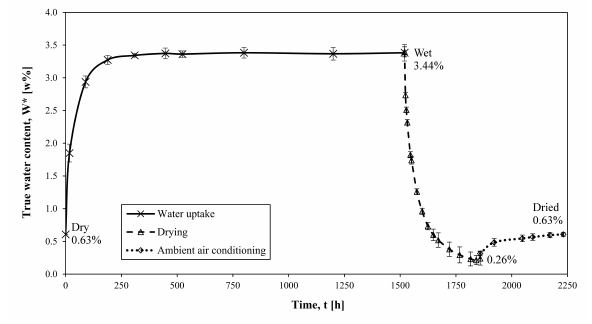
Figure 2: Evolution of true water content of amine-cured epoxy resin during water uptake, drying and conditioning in air.